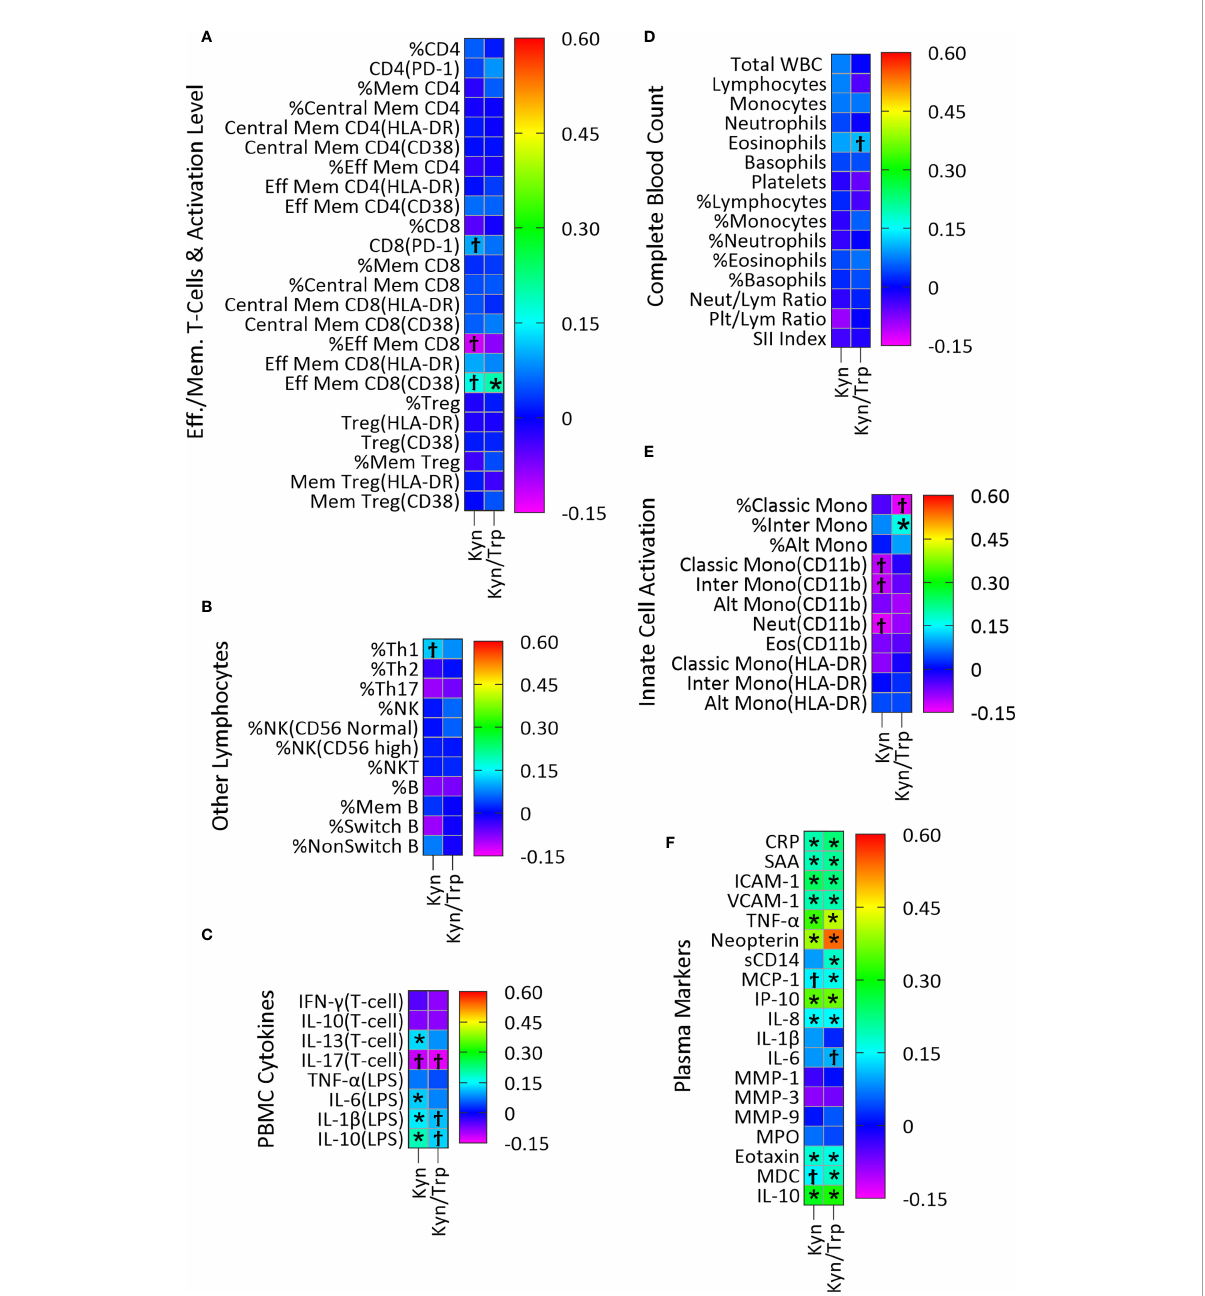
FIGURE 3 Association of plasma Kyn and Kyn/Trp with plasma markers of immune activity in a linear regression model adjusted for age, sex and BMI categories and CMV infection status. Heatmaps (A – F) show coef fi cients of association with adjusted beta values for the six immune groupings (A) Effector/Memory T-cells and activation level (n=24), (B) Other lymphocytes including Th cells, NK, NK T-cells and B cells (n=11), (C) PBMC cytokines (n=8), (D) Complete Blood Count (n=15), (E) Innate cell activation (n=11), and (F) Plasma (n=19). ‘ Ϯ ’ indicates signi fi cant association with unadjusted p values<0.05. ‘ * ’ indicates signi fi cant association with Benjamini-Hochberg adjusted p-values<0.05. (A) PD-1, Programmed Death-1; Mem, Memory; Eff, Effector; (B) NK, Natural killer cells, NKT, Natural killer T-cells; (D) Neut, Neutrophils; Lym, Lymphocytes; Plt, Platelets; SII, (Platelet×Neutrophil)/Lymphocyte; (E) Mono, Monocytes; Alt, Alternate; Inter, Intermediate; Eos, Eosinophils; (F) CRP, C-Reactive Protein; SAA, Serum Amyloid A; ICAM-1/VCAM-1, Intracellular/Vascular cell adhesion molecule; TNF- a , Tumor Necrosis Factor- a ; sCD14, Soluble CD14; MMP, Matrix metalloproteinase; MPO, Myeloperoxidase; MDC, Macrophage-derived